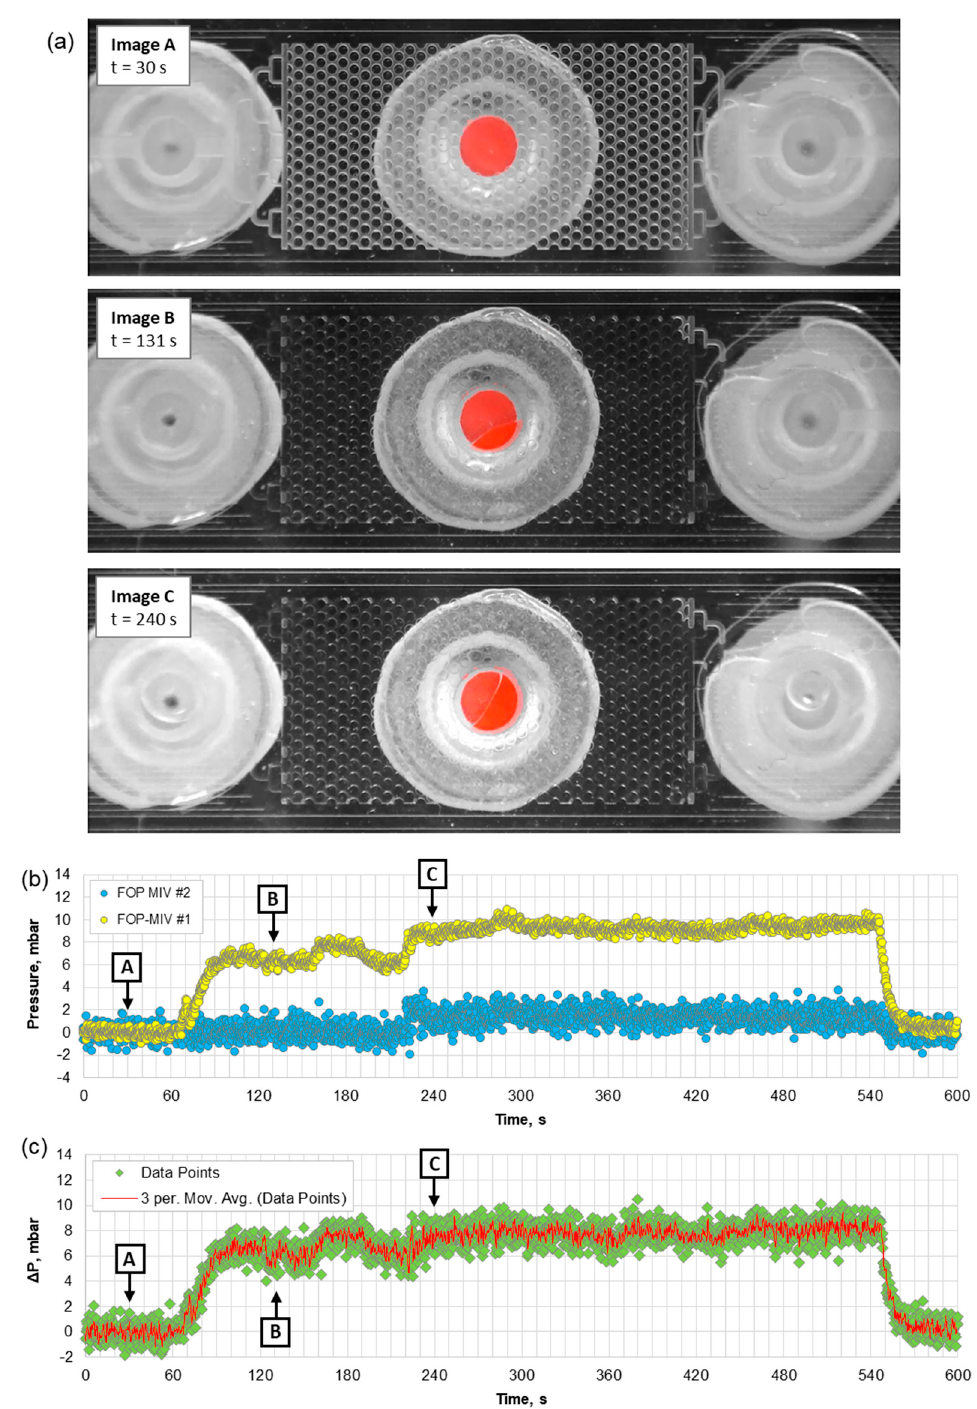
was measured to be 7.9 ± 0.8 mbar. The distribution of DI water within the pattern (see Figure 8a, Image C) did not change for the rest of the injection.